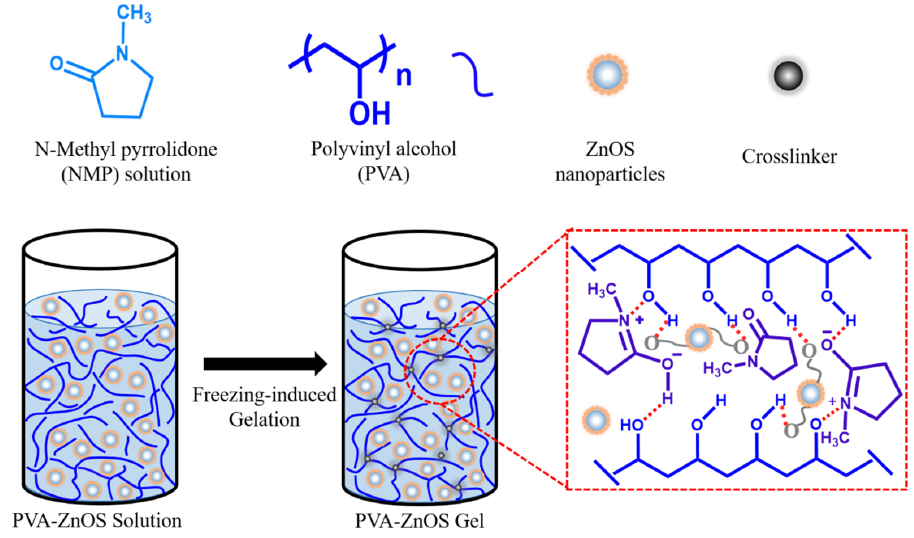
Figure 1. Fabrication process of ZnOS ‐ PVA hydrogels . Photographs in Figure 2a show that pure PVA hydrogel was highly transparent. The incorporation of ZnOS NPs into PVA gel turned its color from clear to white, the intensity of which was enhanced with increased ZnOS concentrations. SEM images of gel surfaces in Figure 2b – d indicate ZnOS nanoparticles (white spots) embedded well inside the gel surface. For further investigation inside the gel ʹ s matrix, PVA, PVA ‐ ZnOS100, and PVA– ZnOS200 gel were cut into small pieces, and cross ‐ sectional views of these fractions were observed by SEM (Figure 2e – g). It was observed that ZnOS particles were encapsulated inside the gel matrix. However, at high ZnOS concentration (PVA ‐ ZnOS200), particles tended to aggregate with each other and the surface of the gel was rougher, whereas some parts appeared cracked (see white circles). EDS of the gels confirmed the Zn, O, and S elements in PVA ‐ ZnOS, only informing the presence of ZnOS in composite gel (Figure S2a,b). XRD patterns showed crystal structures of PVA ‐ ZnOS hydrogels composed of PVA, ZnO, and ZnS phases (Figure 3a). The intense peak at 20° belongs to polymers (PVA) [21,22] and is identified in both PVA and PVA ‐ ZnOS hydrogels. Diffraction peaks at higher angles were fitted to cubic ZnS (JCPDS#04 ‐ 016 ‐ 6848) and wurtzite ZnO (JCPDS#04 ‐ 016 ‐ 6648).